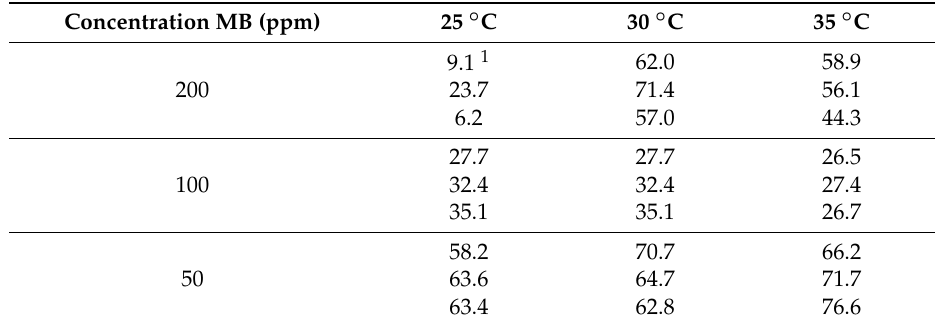
Table 2. Effect of the initial dye concentration variable and temperature on the percentage (%) in MB bioremediation from data of Figure